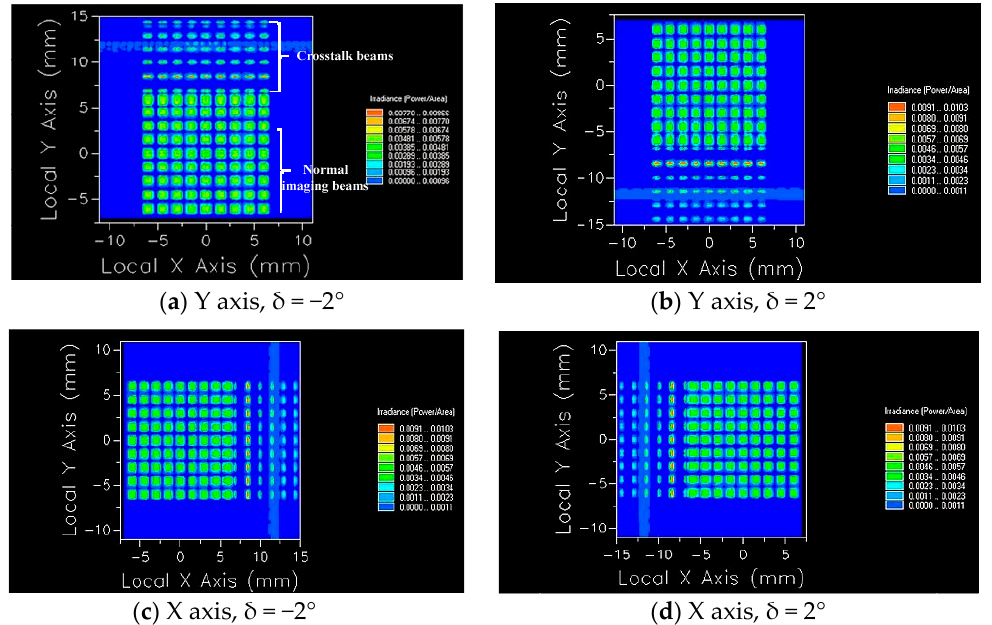
Figure 13. Imaging diagrams under several characteristic situations.